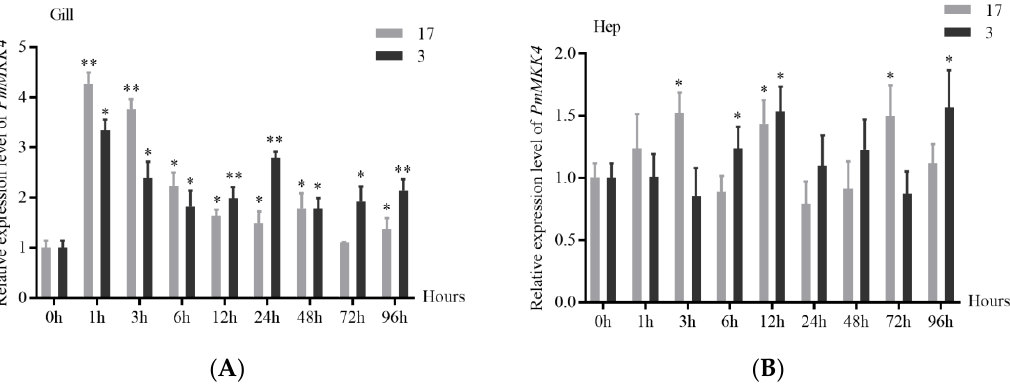
Figure 6. Relative expression levels of PmMKK4 in hepatopancreas ( A ) and gill ( B ) under acute low-salinity stress. Quantitative RT-PCR was performed to determine the expression of PmMKK4 in gill ( A ) and hepatopancreas ( B ) of P. monodon at different time intervals (n = 3 for each group) after the salinity drops sharply to 17 and 3, ranging from 0 to 96 h. Vertical bars represent the mean ± S.E. (n = 3). Significant differences are indicated by * ( p < 0.05) and ** ( p < 0.01).